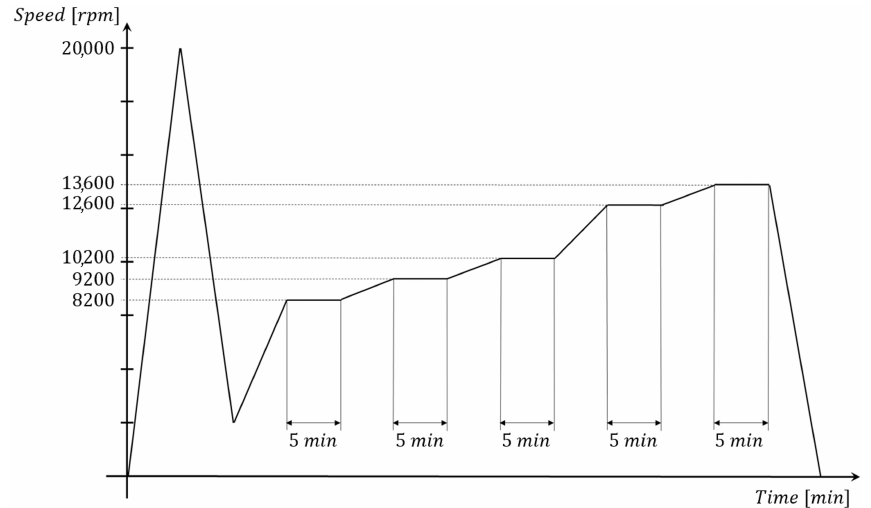
Figure 12. Experimental procedure to evaluate the critical speeds and the onset of the thermal